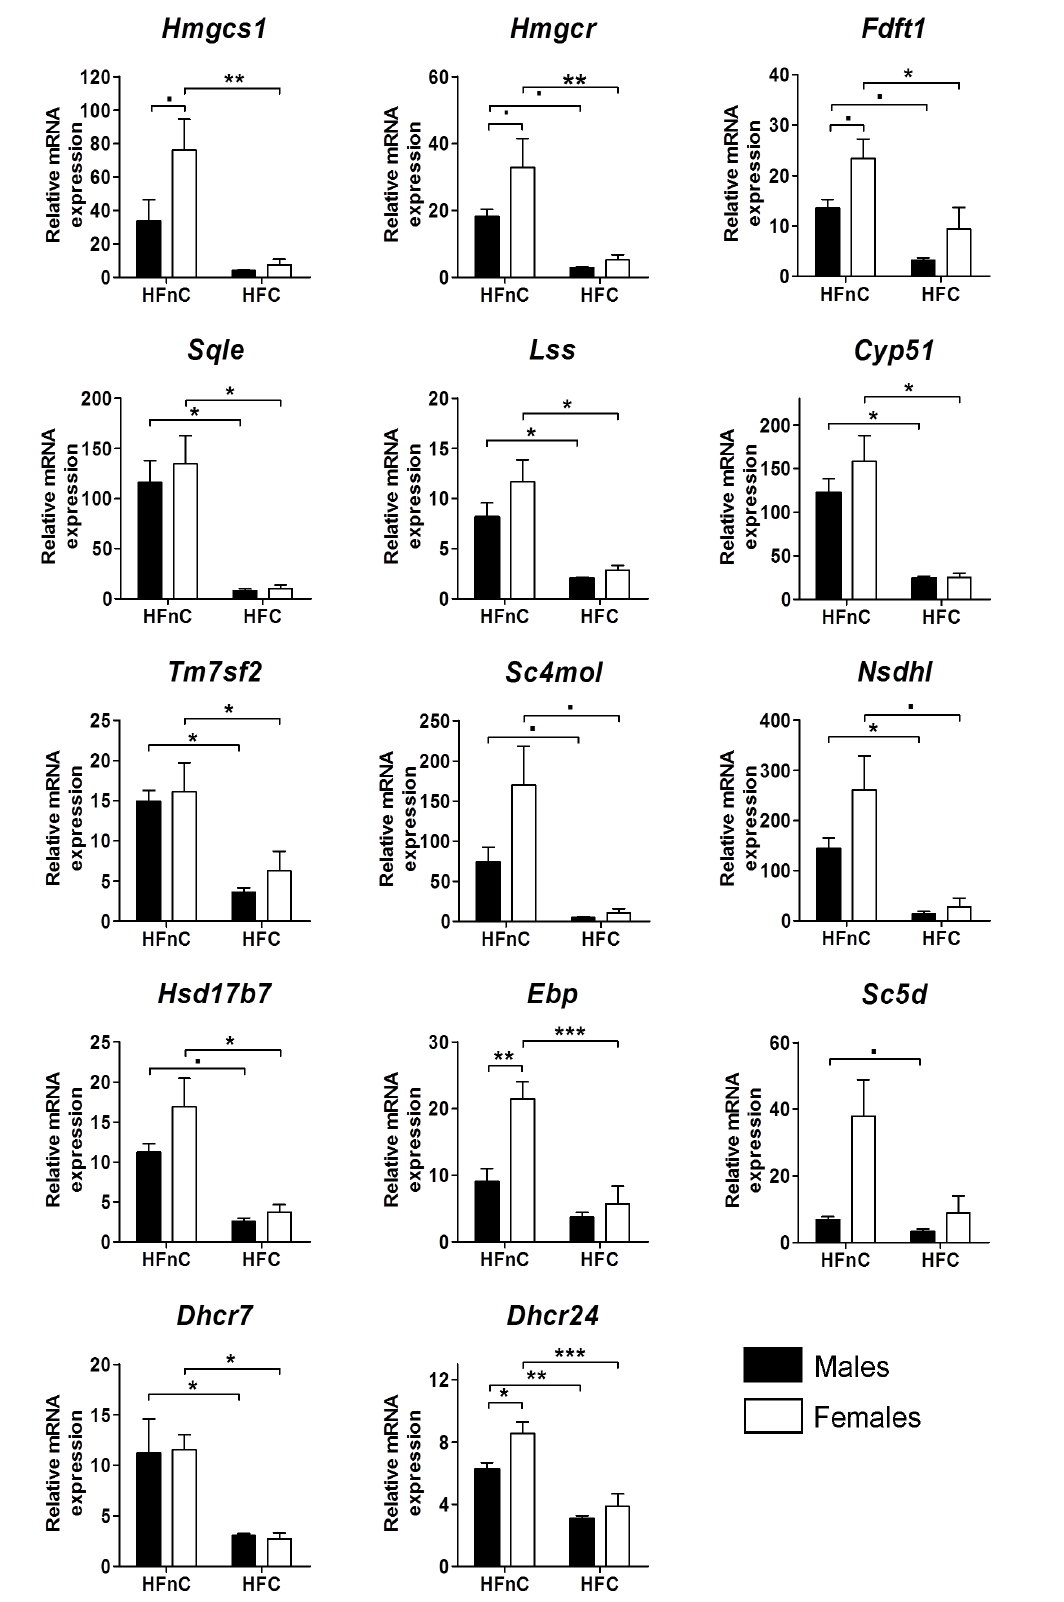
Figure 2. Relative mRNA expression of cholesterogenic genes in the liver. Black columns represent male and white columns female mice. Error bars represent SEMs. N = 5; ˙ p < 0.1; * p < 0.05; ** p < 0.01; *** p <